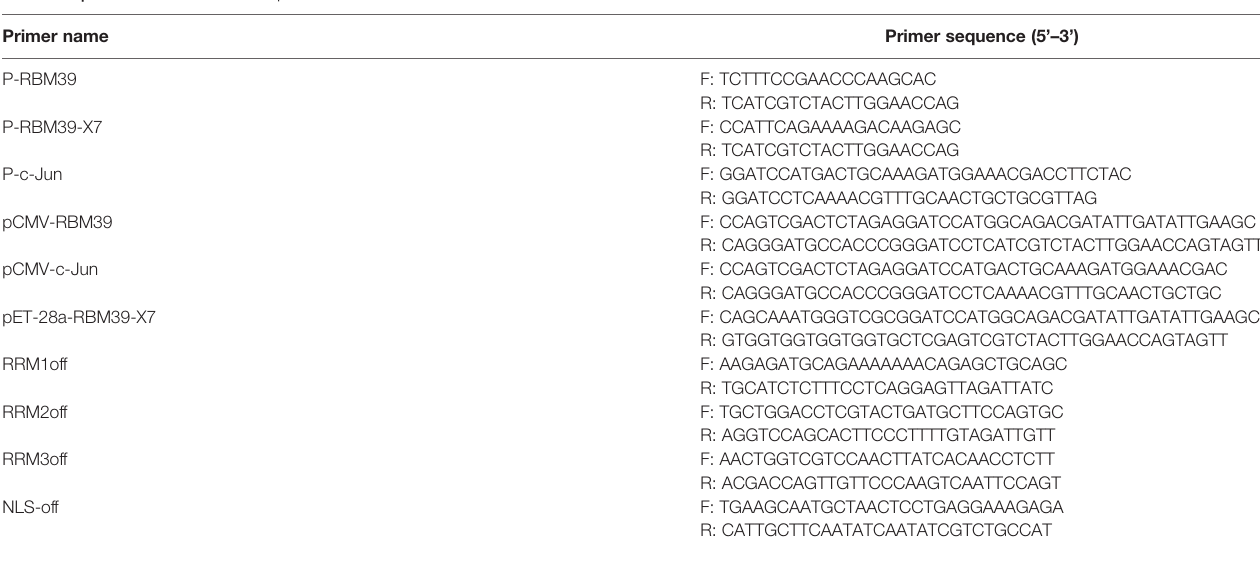
TABLE 1 | Primers used in PCR ampli fi